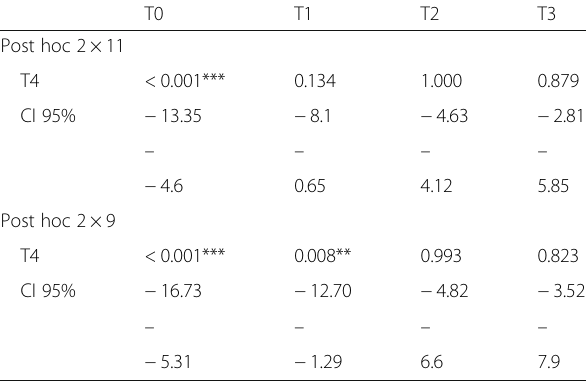
Table 3 Results of Tukey post hoc test 2 × 11 and 2 × 9 intra- group comparison and respective confidence intervals (CI